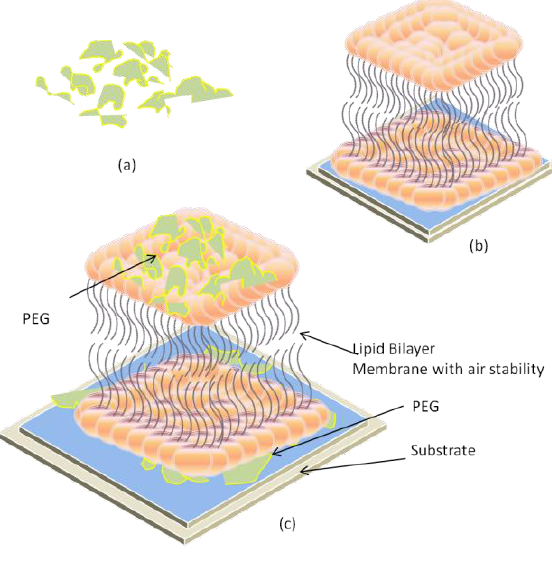
Figure 6. Air stability of a lipid membrane is increased using a Phosphatidylethanolamine (PEG) film. ( a ) PEG; ( b ) Simple solid supported LBM; ( c ) Vesicles with PEG on